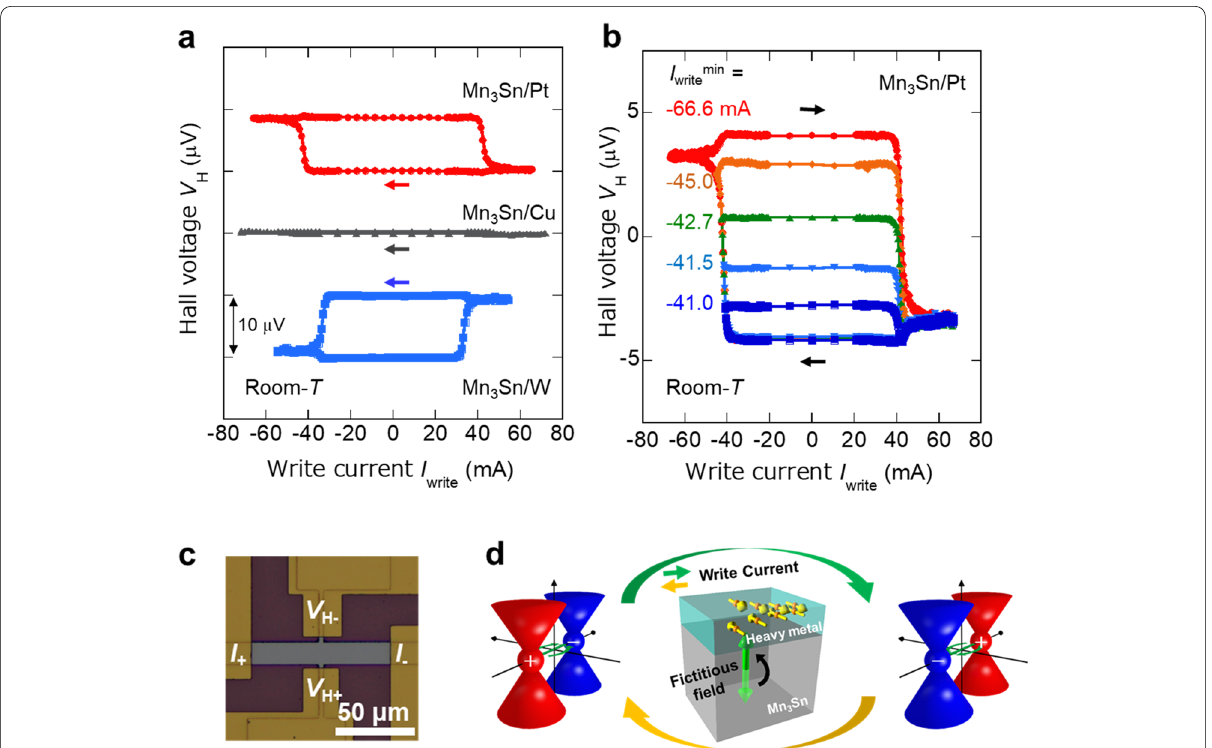
Fig. 9 Current-driven magnetic switching of an antiferromagnet [38]. a Write current I write dependence of the Hall voltage V H in a bilayer thin film Hall device of Weyl antiferromagnet